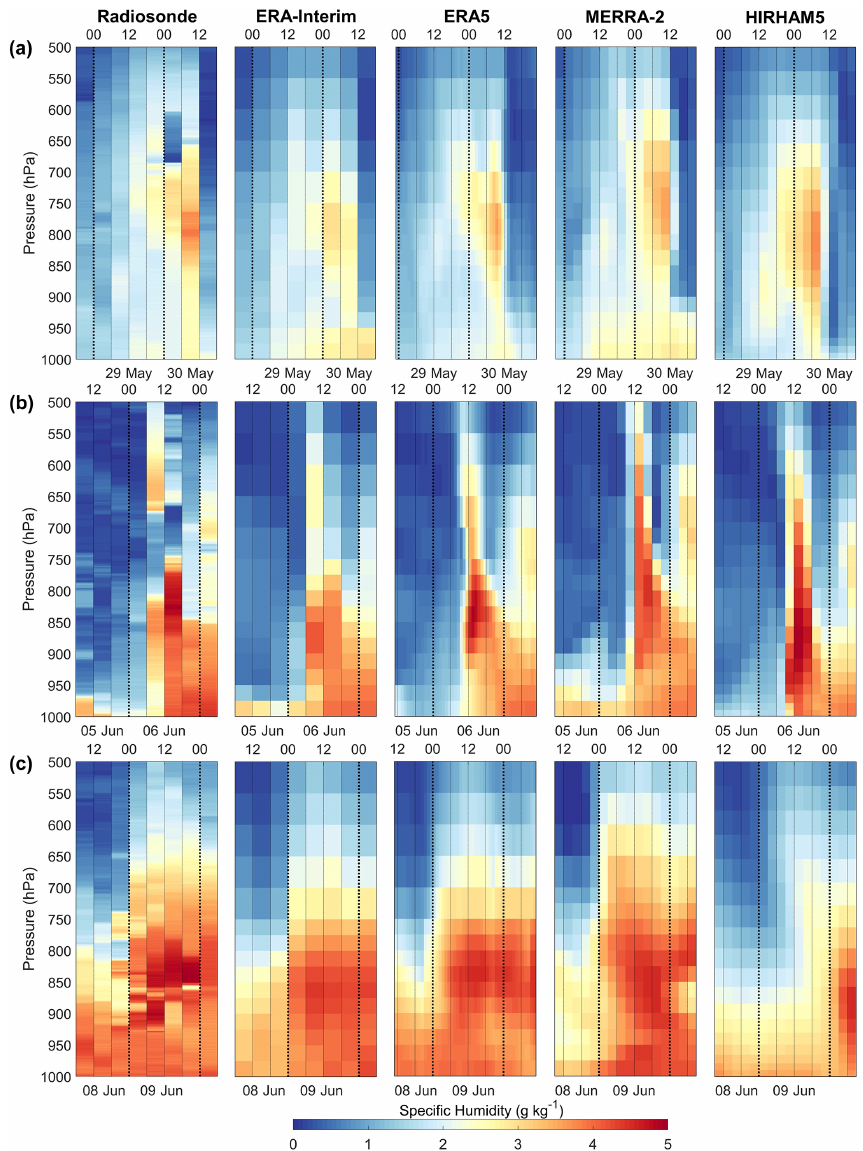
Figure 7. Temporal evolution of vertical profiles of specific humidity (gkg − 1 ) at Ny-Ålesund, based on radiosondes, reanalyses (ERA- Interim, ERA5, and MERRA-2), and the HIRHAM5 model, during the 30 May event (a) , the 6 June event (b) , and the 9 June event (c) . Time steps on the x axis mark the end of the observations/reanalyses/model. Figure S10 shows all datasets.